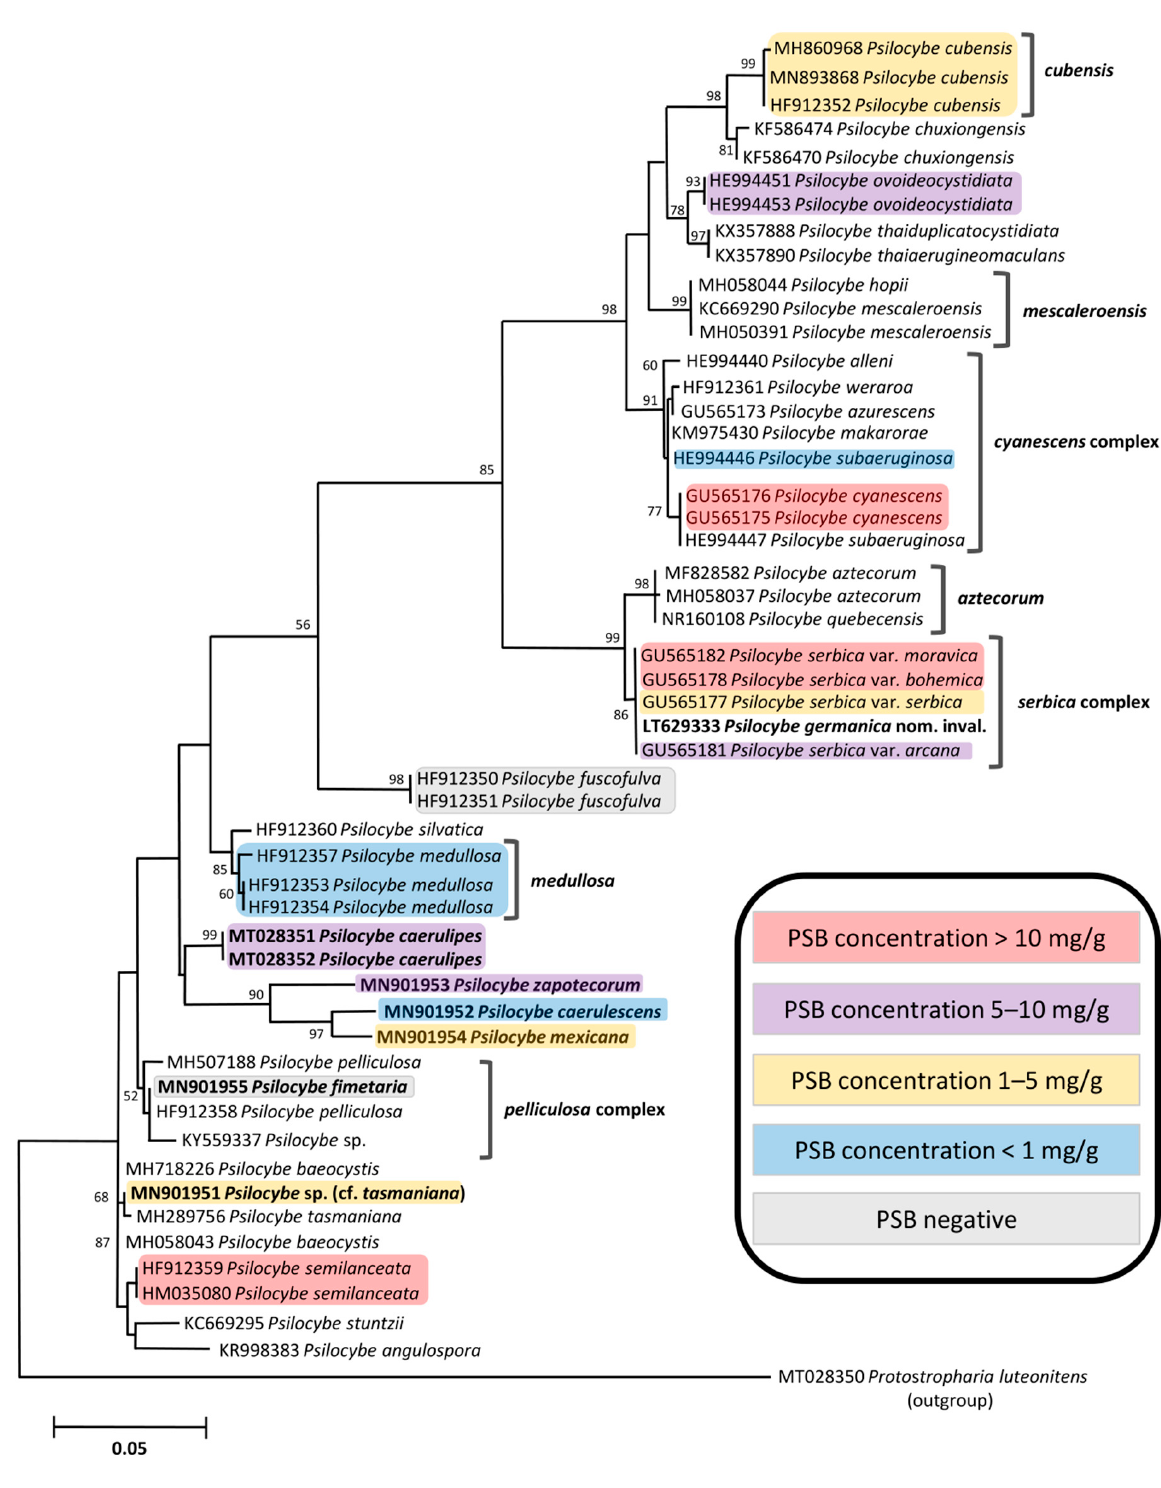
Figure 3. Phylogenetic placement of the studied Psilocybe species based on the ITS rDNA sequences (maximum likelihood tree computed in MEGA X). Bootstrap support values (>50, based on 1000 replicates) are presented along the branches. Protostropharia luteonitens was used as the outgroup to root the tree. The ITS rDNA sequences generated within this study are in bold. Information on psilocybin (PSB) concentrations is indicated.